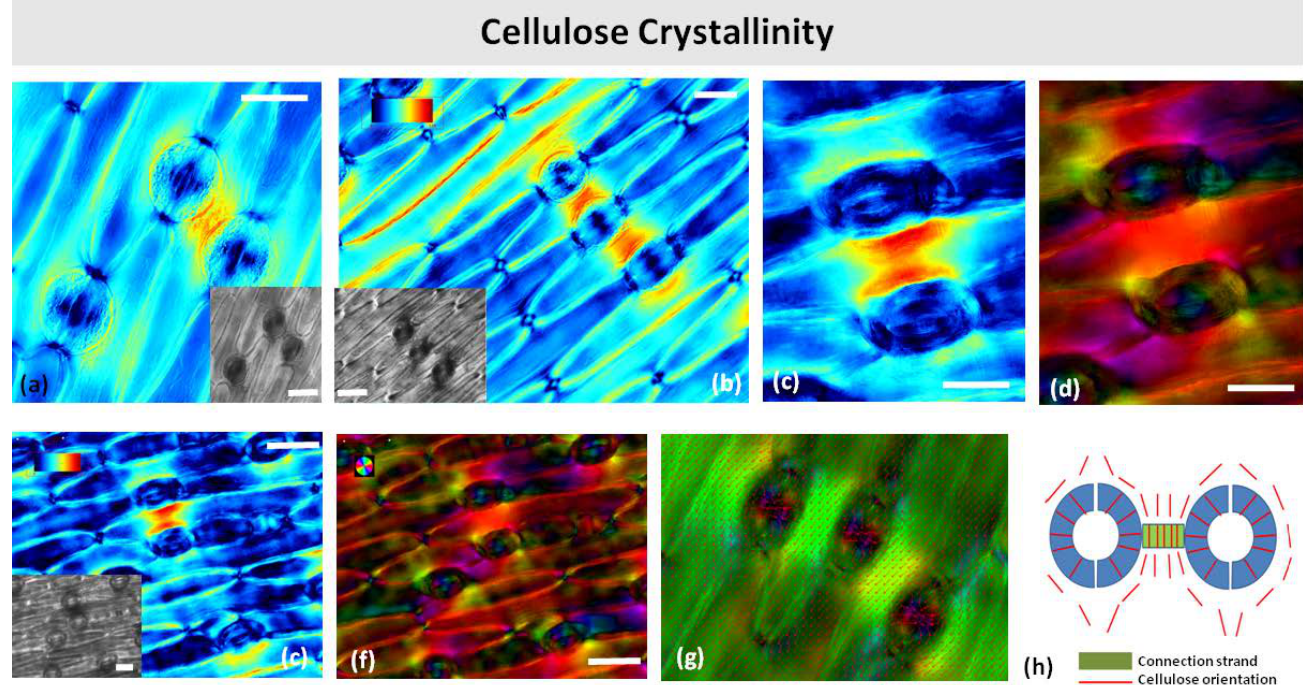
Figure 10. Polarized light color-coded PolScope images of crystalline cellulose retardance (crystal- linity) ( a – c , e ) and orientation ( d , f , g ) in paradermal sections of Pancratium maritimum leaves. ( a , b ) Stomata with connection strands by DIC optics (insets in a , b , e ) and cellulose retardance images ( a – c , e ). ( h ) Schematic representation of cellulose orientation in a stomatal pair with connection strand. Orientation scale color codes the cellulose microfibrils’ orientation. Retardance scale color codes the retardance range (0–120nm). Scale bars: 20 μm.